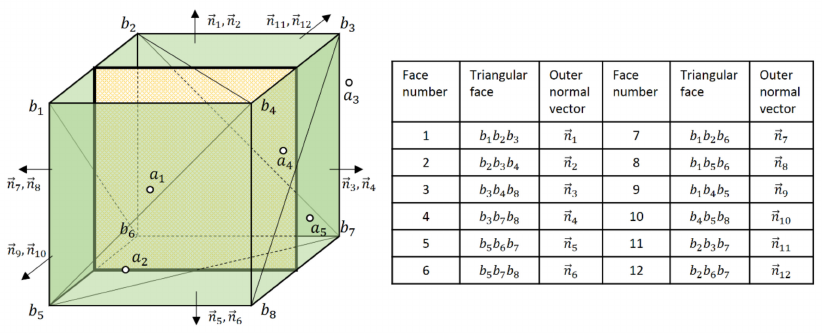
Figure 3. Some of points in A and the convex hull of B . The hollow dots represent points in A and the green cube represents the convex hull of B . Every three vertexes compose a triangular face of convex → n k , and k is the face hull and it has an outer normal vertor